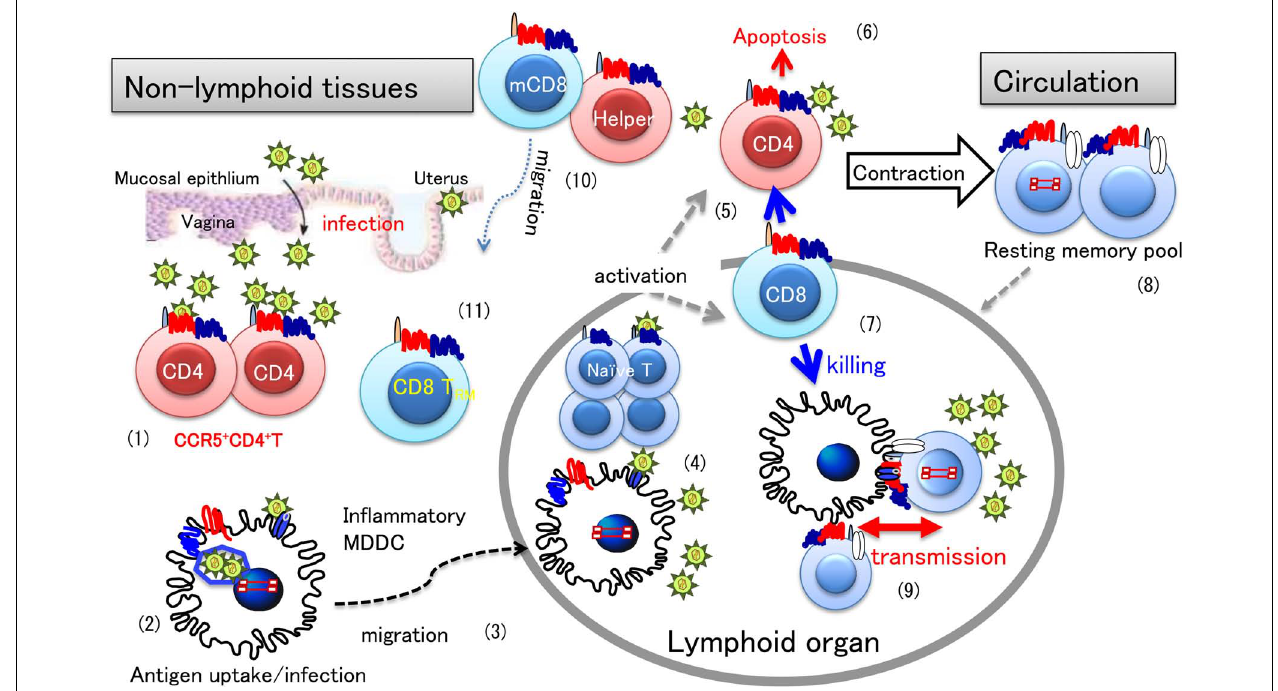
FIGURE 2 | HIV infection andT cell differentiation during primary and memory antiviral immune responses. A general view of antiviral immune responses focusing on HIV-1 infection is illustrated. Once HIV invades the vaginal mucosa, infection mostly occurs in activated CD4 + CCR5 + T cells (1). Resident DCs in the submucosa engulf virions or HIV-infected cells (2), and then migrate to the draining lymph nodes (3), where an antiviral immune response is initiated (4). In a primary immune response, antigen-specific T cells are differentiate into effector cells. During the effector phase,